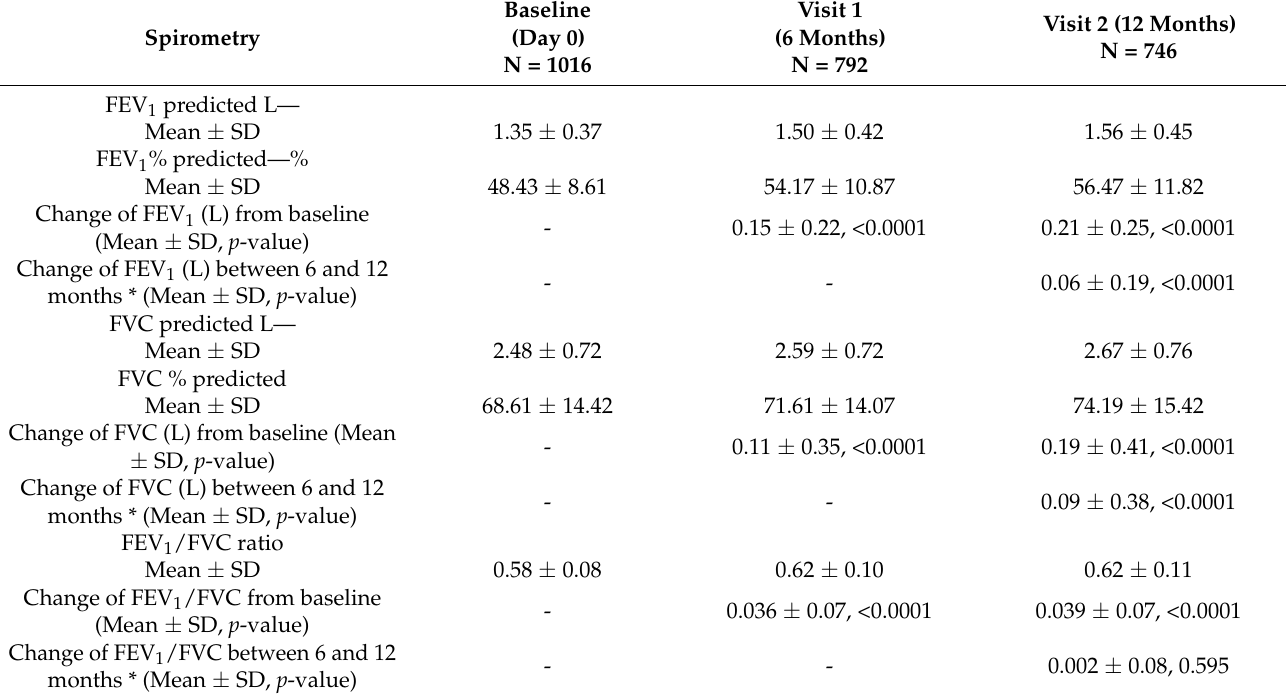
Table 3. Spirometry results at 0, 6 and 12 months and change from baseline and 6 months for the total number of